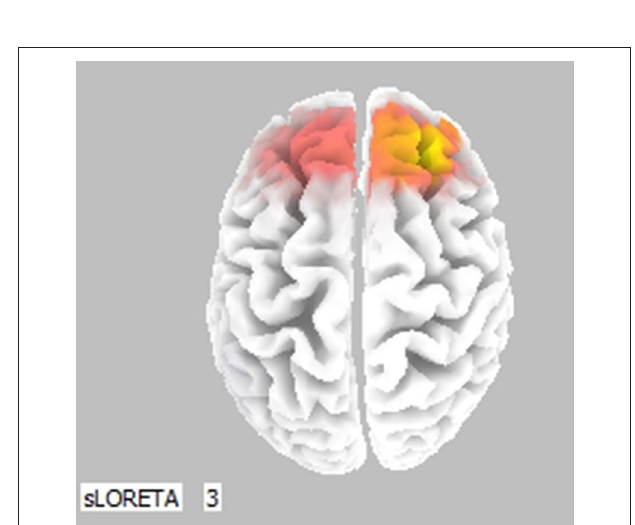
FIGURE 8 | Statistically significant cerebral activity was estimated by LORETA software for the Lower Alpha Band for comparison of two pieces of information in (SN, BP) and in (0, SN + BP). A similar result was generated in the Upper Alpha Band. Orange areas suggest a significant increase in cortical activity for the first scenario (SN, BP). For this experimental condition, there were no important difference in the cortical activities estimated by the two different frequency